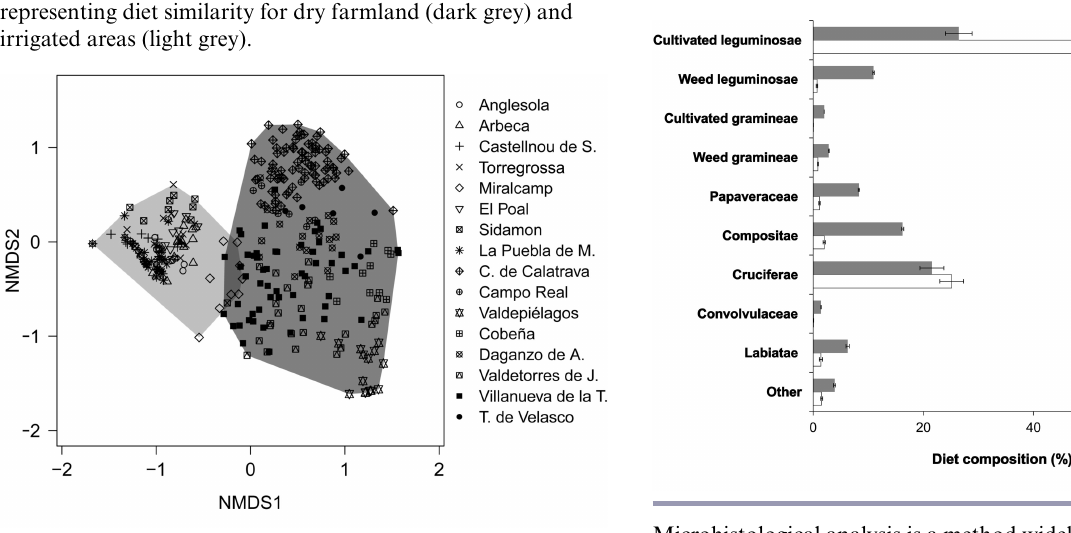
Fig. 3 . Percentage (mean±SE) of the main plant families in the diet of Little Bustards ( Tetrax tetrax ) in irrigated (white columns) and dry farmland areas (grey columns) in